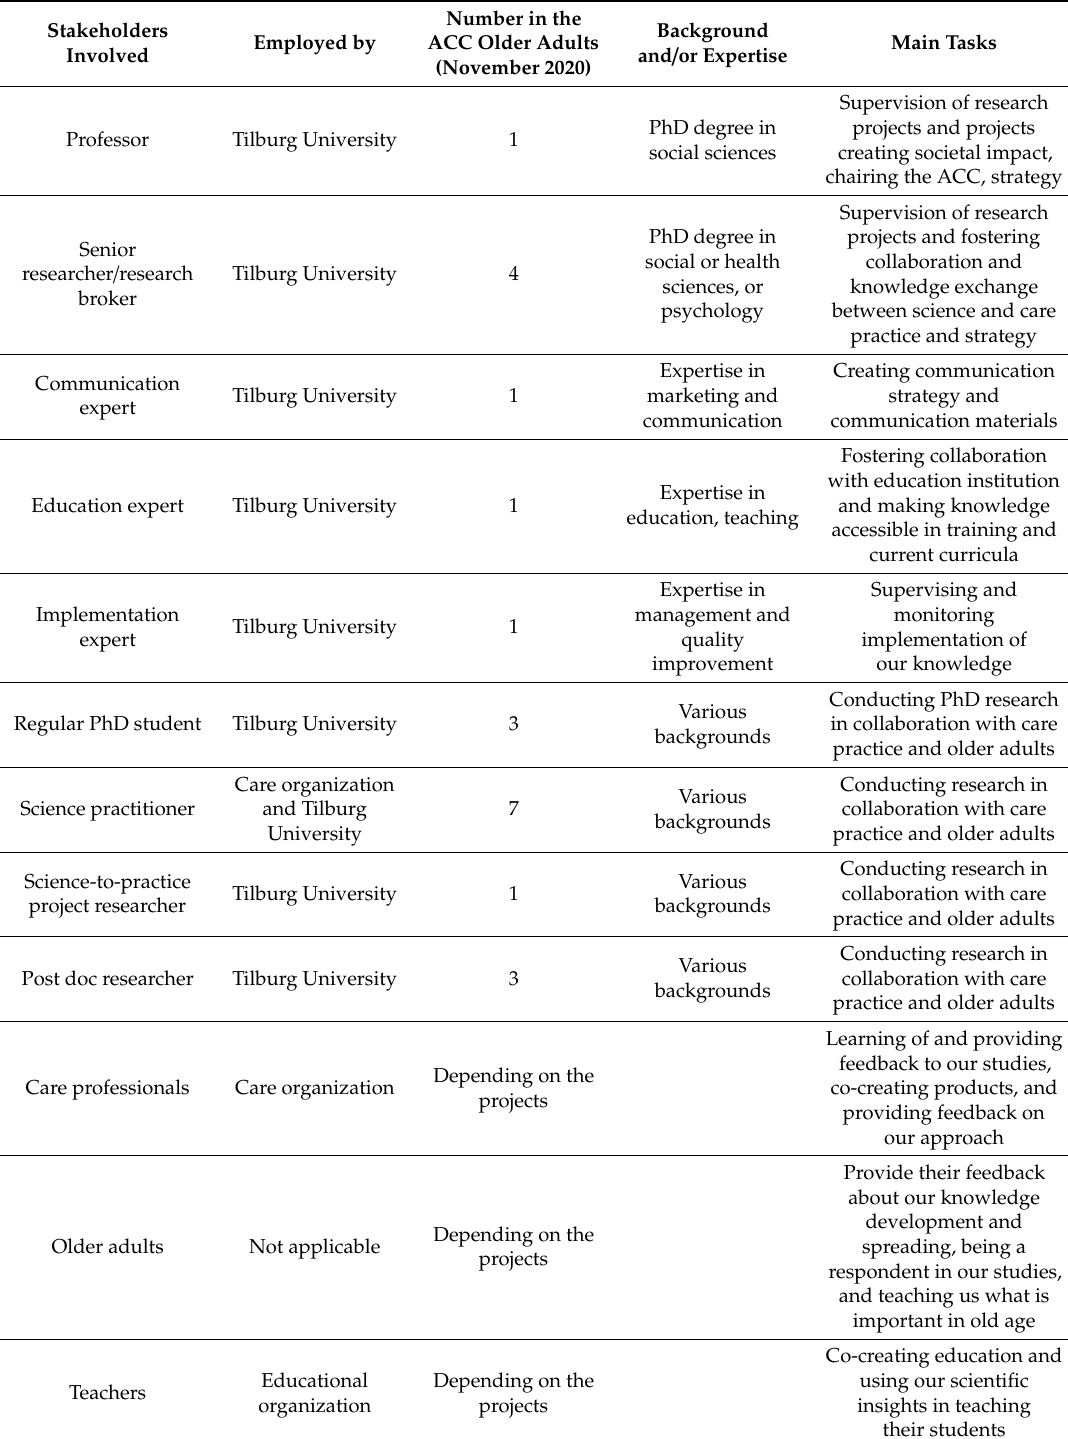
Table 1. Stakeholders involved in the ACC Older